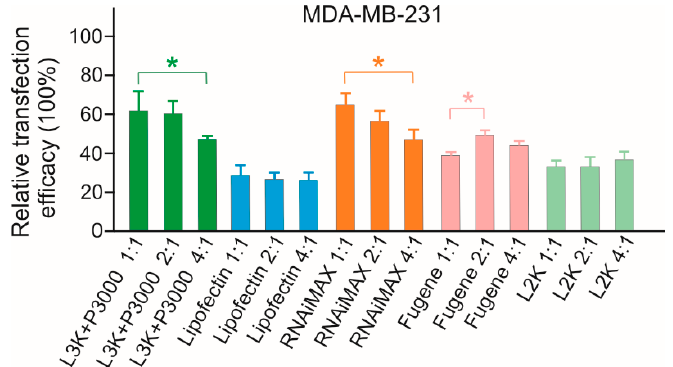
Figure 2. In vitro transfection efficiency of transfection reagent (TR)/SSO complexes at different ratios ( v / w ) in MDA-MB-231 cells. Cells were transfected with TR/DNA complexes in the absence of serum with three different amounts of SSO. L3K: Lipofectamine 3000, L2K: Lipofectamine 2000. * p < 0.01.